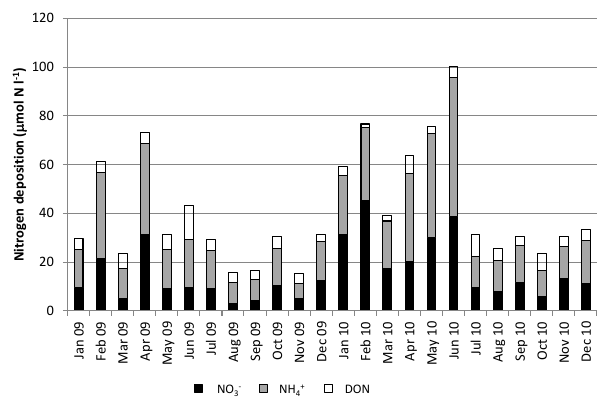
Figure 2. Volume-weighted monthly average concentrations of NH + (grey), NO − (black) and DON (white) in wet-only precipi- 4 3 tation.